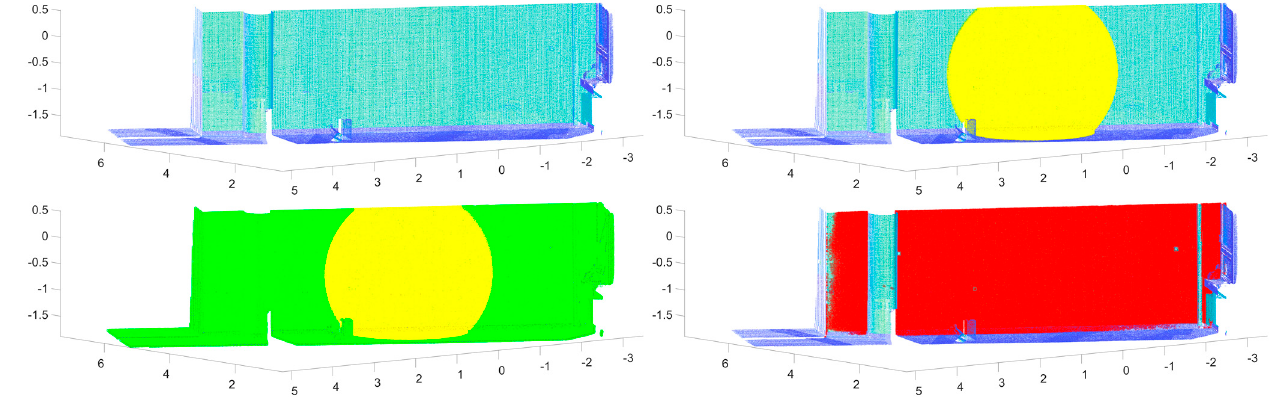
Figure 2. The plane segmentation process by the proposed approach: the initial point cloud ( top-left ), the approximately 102 thousand nearest points ( top-right ), the approximately 1,6 million nearest points ( bottom-left ), and the inliers for the given plane ( bottom-right ).